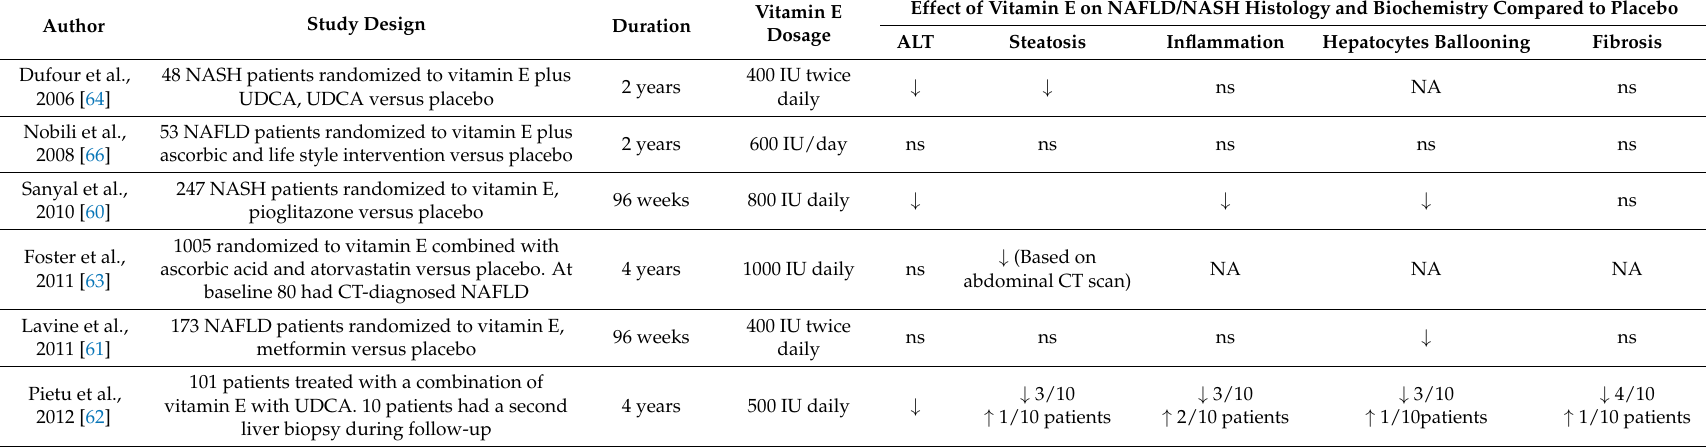
Table 1. Effects of Vitamin E administration in patients with